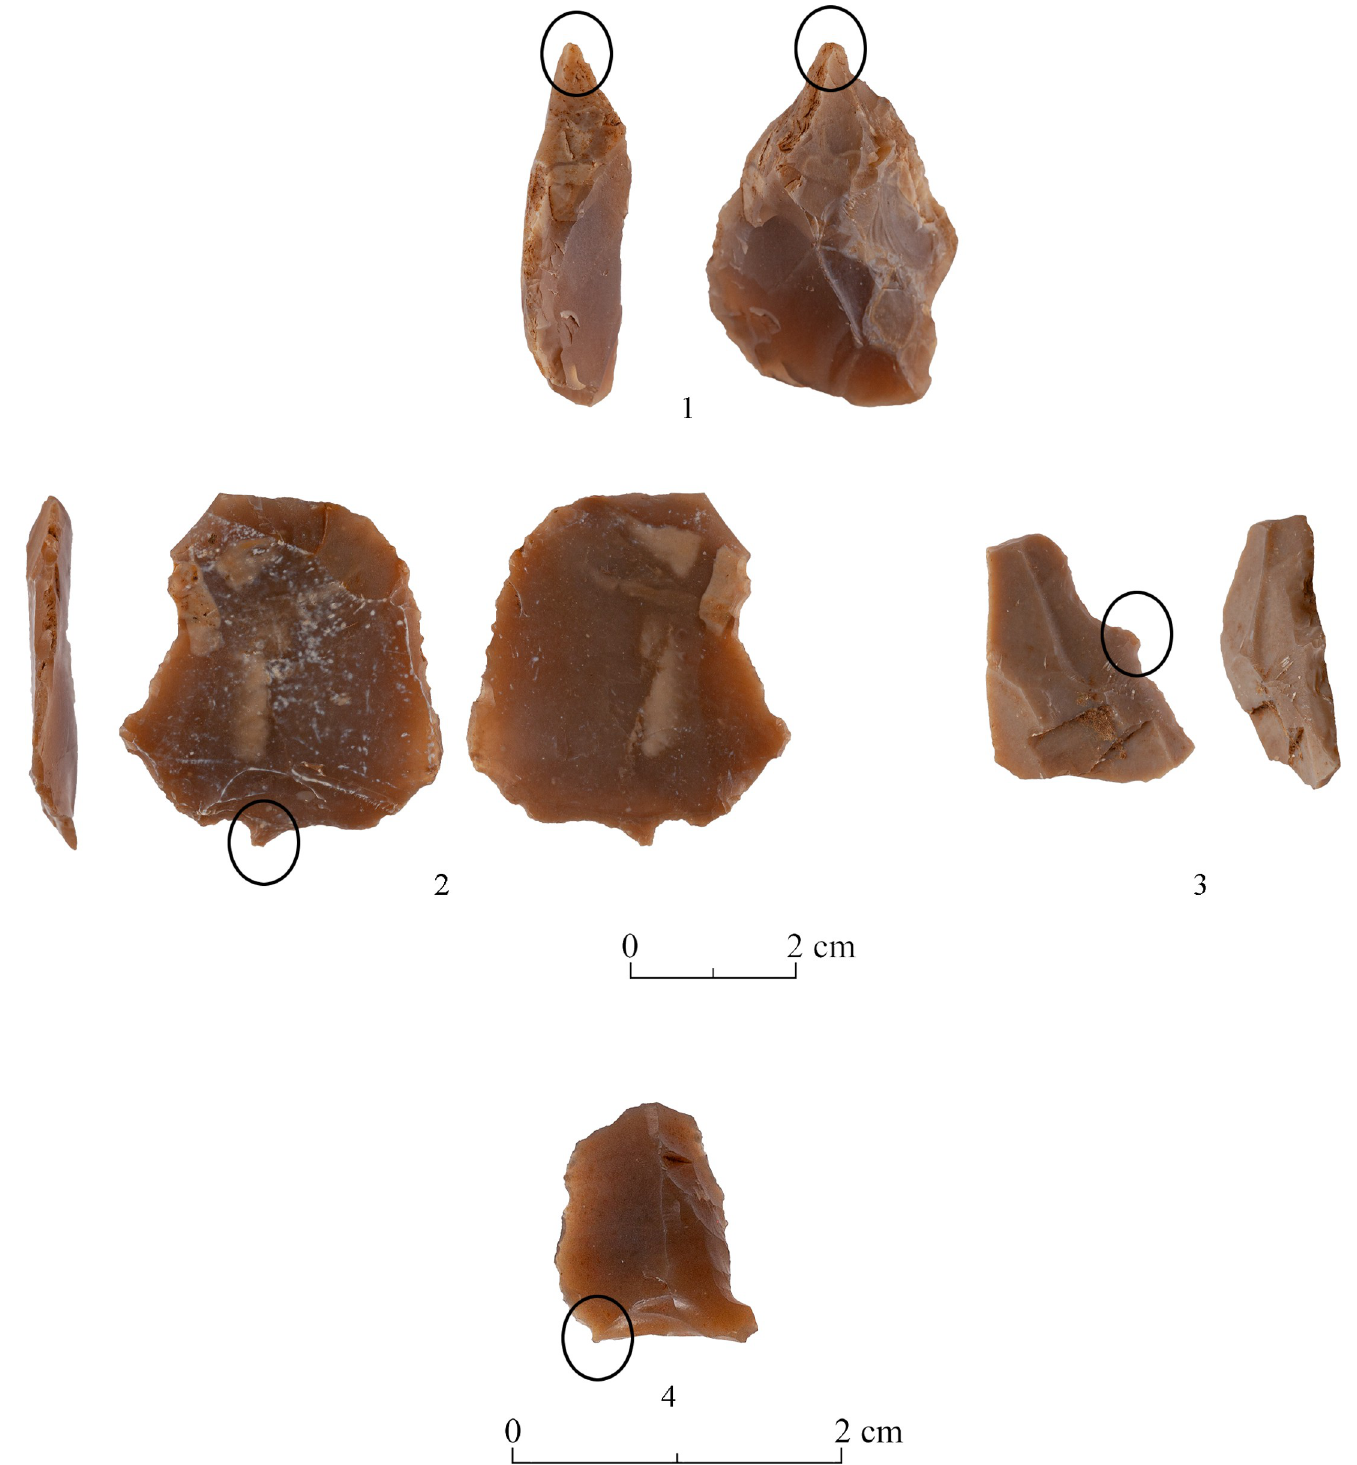
Fig 22. Borers and awls: 1–4.